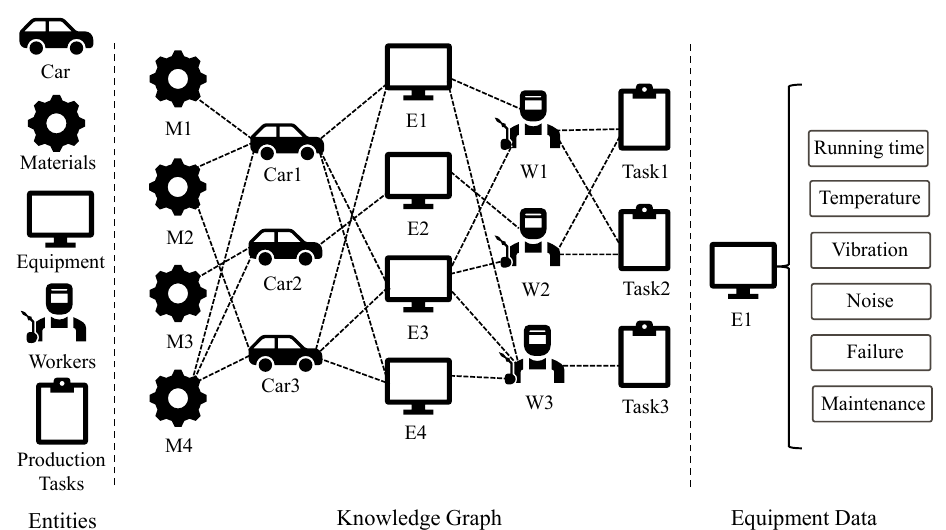
Figure 1. An example of car manufacturing scheduling recommendation with KG. Considering different models of cars as users, Car1 often uses E1, E2 and E3 on the production line, and commonly uses M2 and M3, similar to the production line situation of Car3. When the production demand of Car1 suddenly increases, the recommendation system will suggest transferring some production tasks to the production line of Car3 to reduce the pressure.